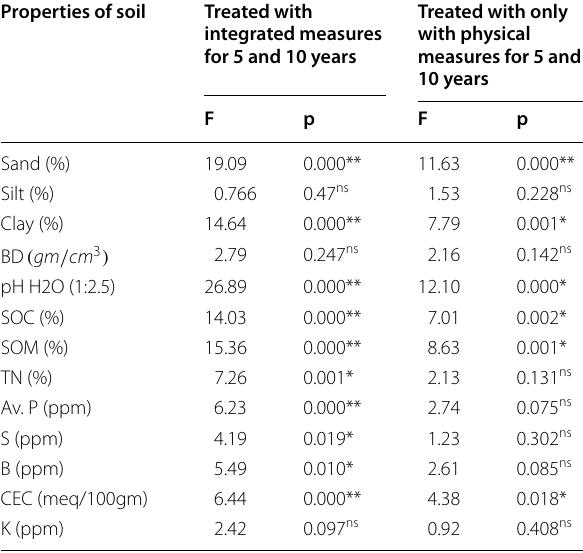
Table 5 The effect of ALM practices on selected soil quality indicators between intervention types and treatment age